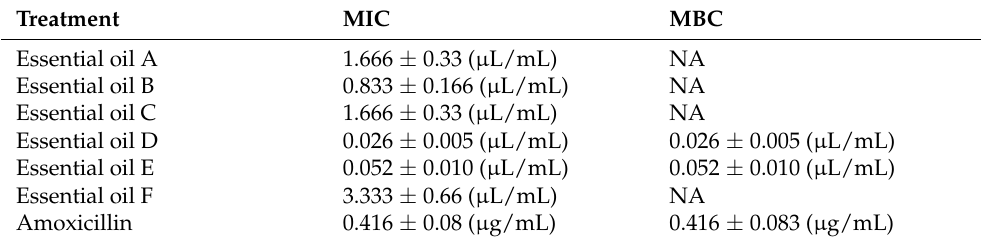
Table 2. MICs and MBCs of different treatments against C. perfringens